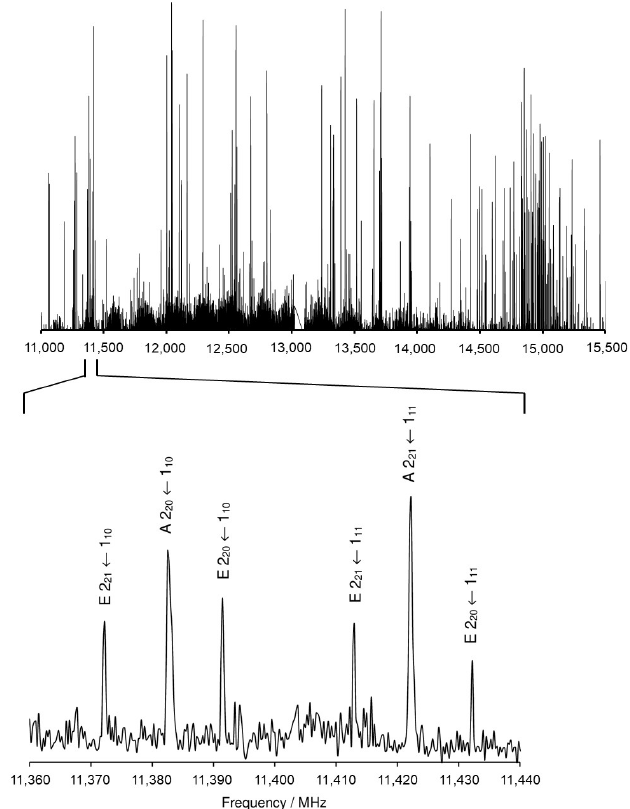
Figure 2. The survey spectrum of MHO recorded from 11,000 MHz to 15,500 MHz. A portion of the scan from 11,360 MHz to 11,440 MHz is illustrated in an enlarged scale where assigned lines are labeled with their corresponding quantum numbers J , K a , K c and torsional species (A or E). They all belong to conformer I. The intensities are in arbitrary units and a logarithmic scale.